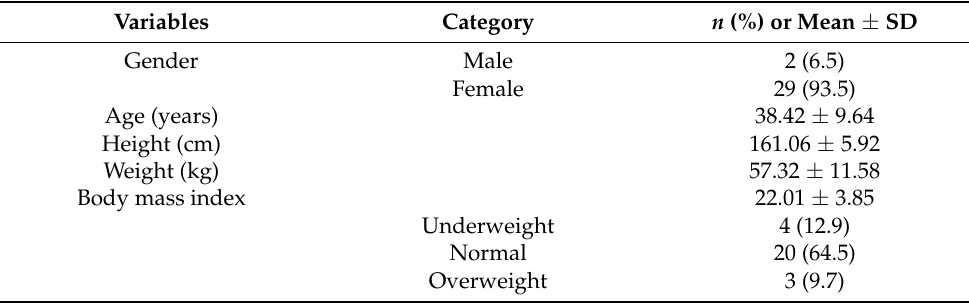
Table 1. General Characteristics of Subjects ( N =